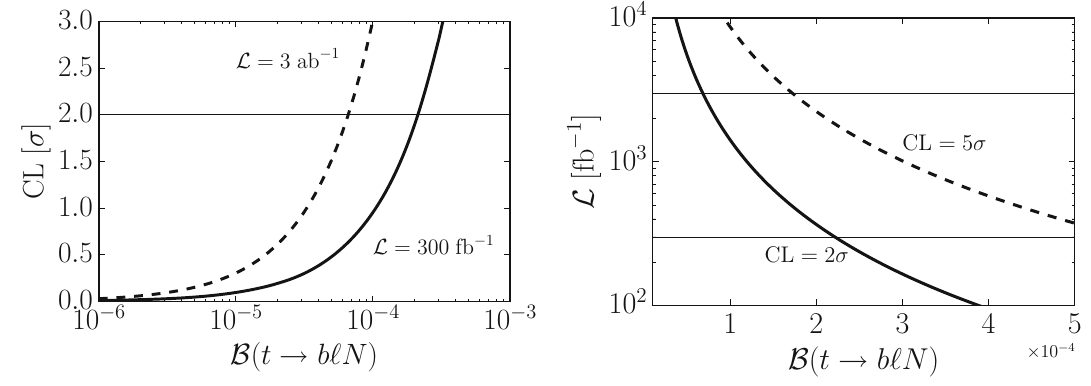
Fig. 4 Left: LHC sensitivity to t → b (cid:4) N as a function of the branching ratio for two values of the collected luminosity. Right: Luminosity required to probe t → b (cid:4) N to 2 σ and 5 σ as a function of the branching ratio. In both cases we rely on the analysis based on the asymmetry defined in Eq.